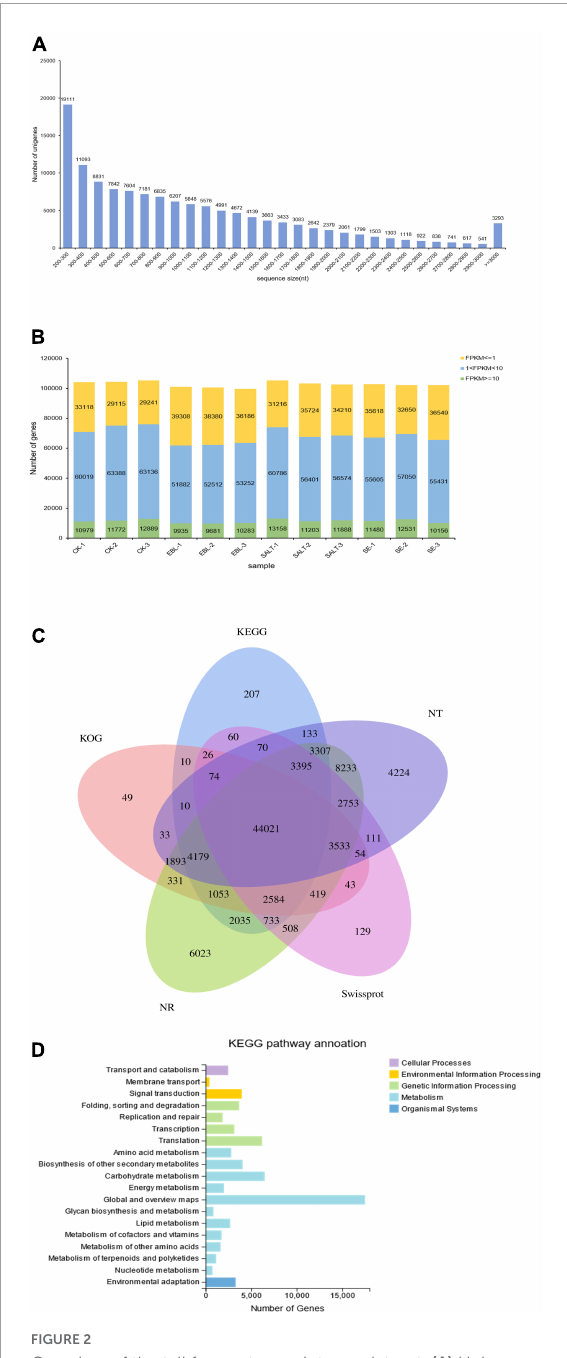
FIGURE2 Overview of the tall fescue transcriptome dataset. (A) Unigene length distribution; (B) Number of genes in different FPKM intervals for each sample; (C) Venn diagram of KEGG, NT, NR, KOG, and Swissprot annotation results of the bermudagrass reference transcriptome; (D) Distribution and quantity statistics of KEGG functions.